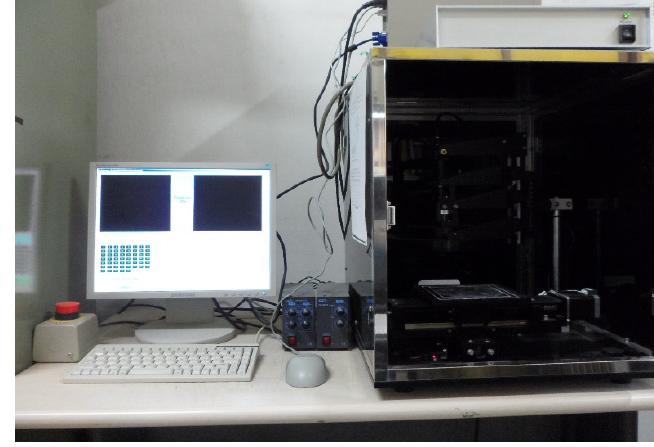
Figure 4. Image analysis device (HF-MA C01).